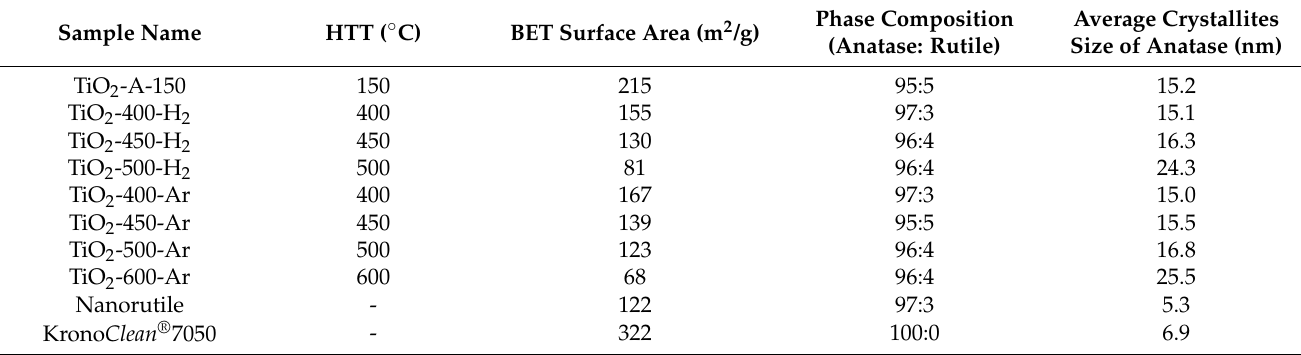
Table 1. The phase composition, average anatase crystallites size, and BET surface area of the prepared and commercial titania